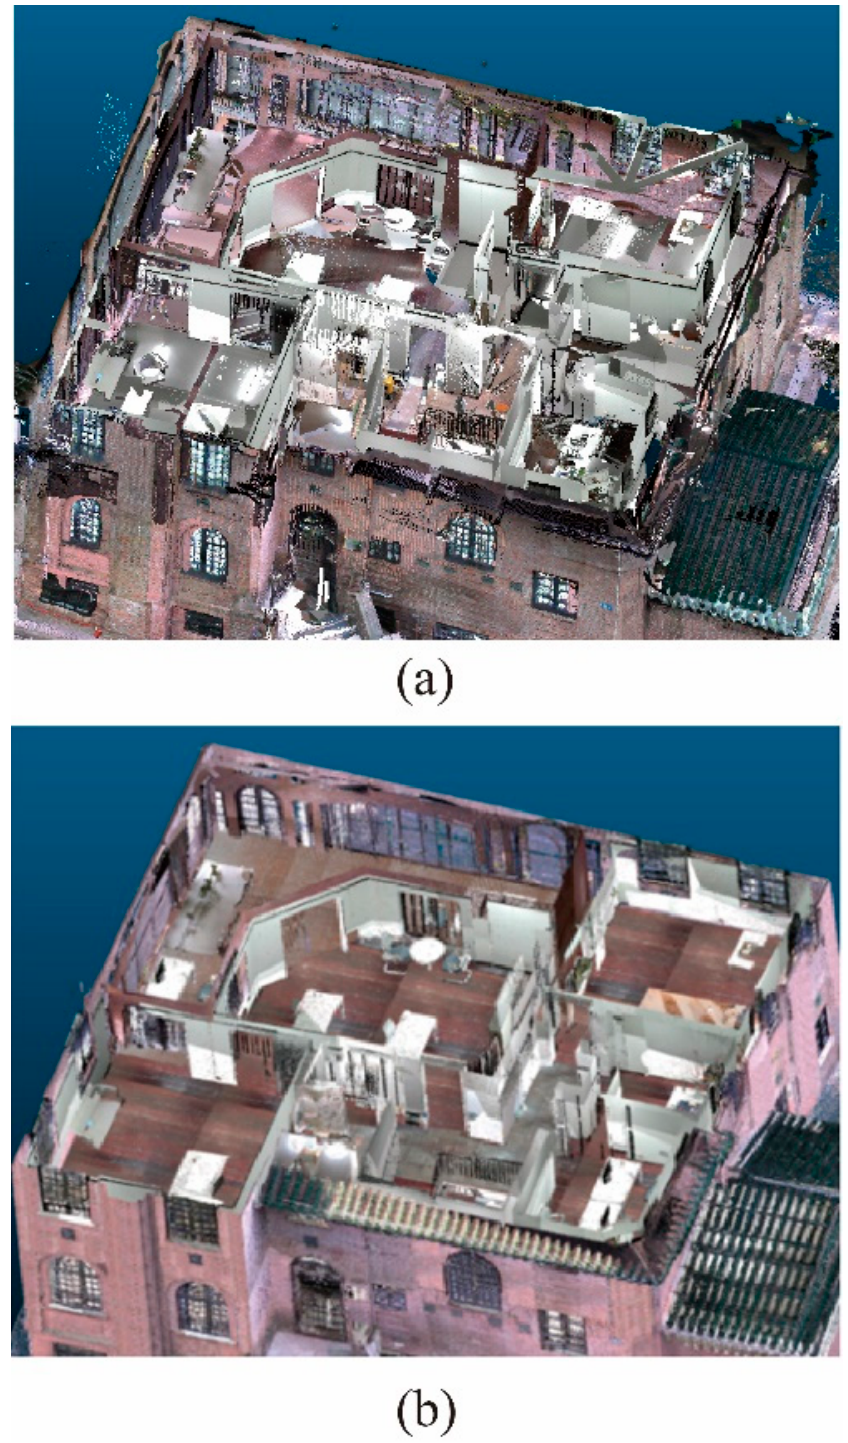
Figure 14. Entire point clouds of the Wesley House: ( a ) the original registered point cloud; ( b ) registered point cloud after the proposed colorization method is applied.